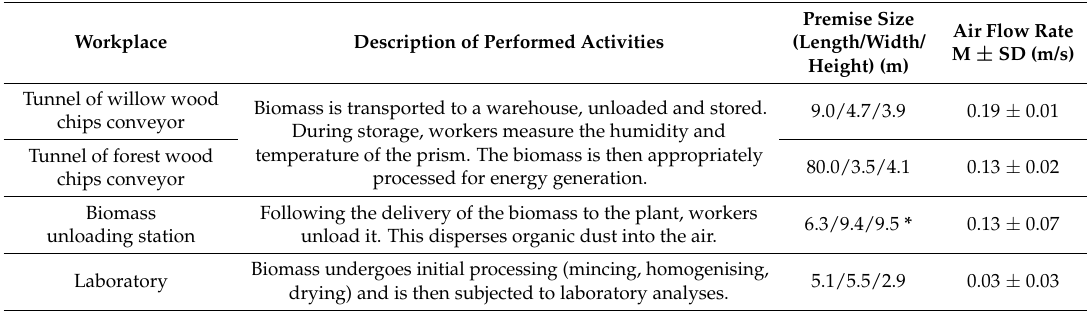
Premise Size Air Flow Rate (Length/Width/ M ± SD (m/s) Height) (m)